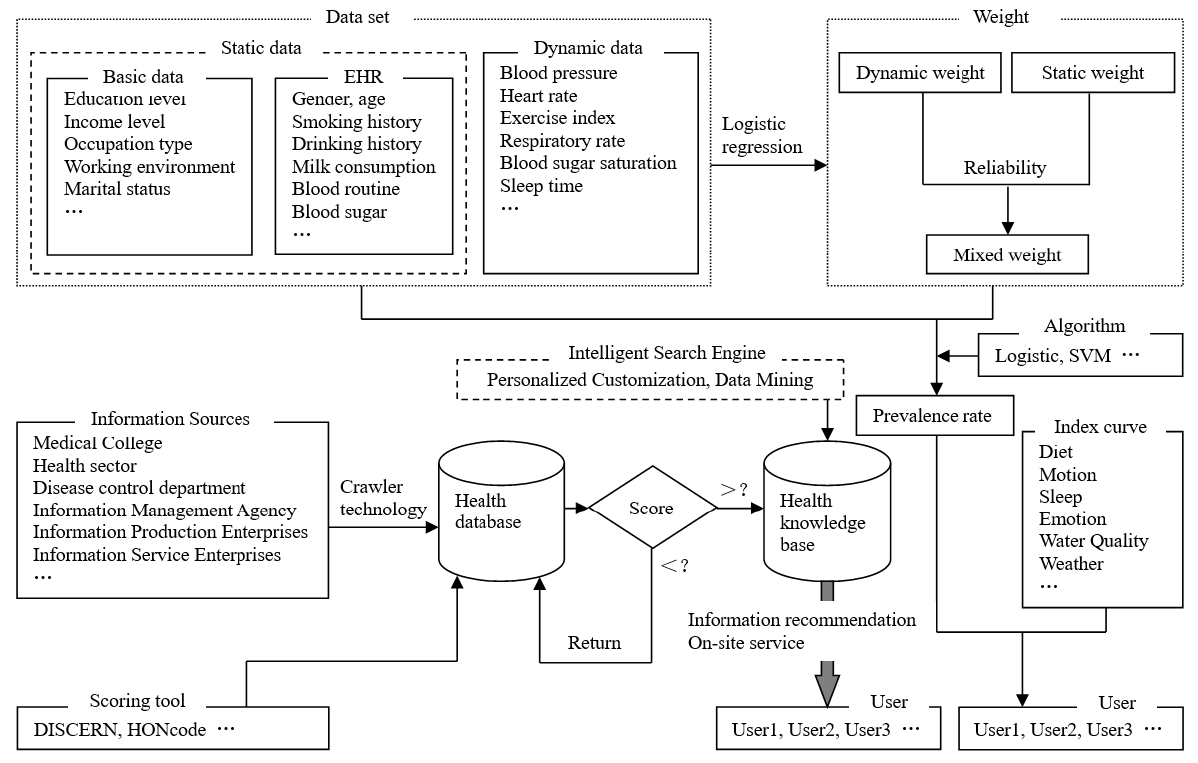
Fig. 1 Technical Roadmap of Health Information Precision Service